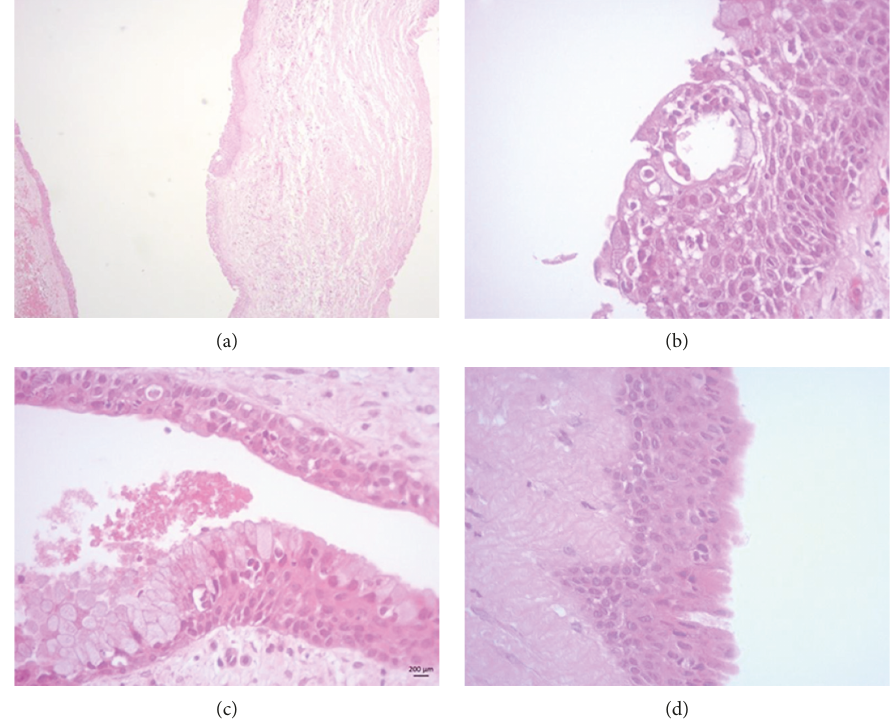
Figure 2: Microscopic features of the GOC. (a) Cystic cavity lined by nonkeratinized strati fi ed squamous epithelium of varying thickness. (b) Duct-like structures observed in the cystic lining. (c) Presence of numerous goblet cells. (d) Note the presence of eosinophilic cuboidal cells. Slides stained with haematoxylin and eosin. Original magni fi cations: 50x and